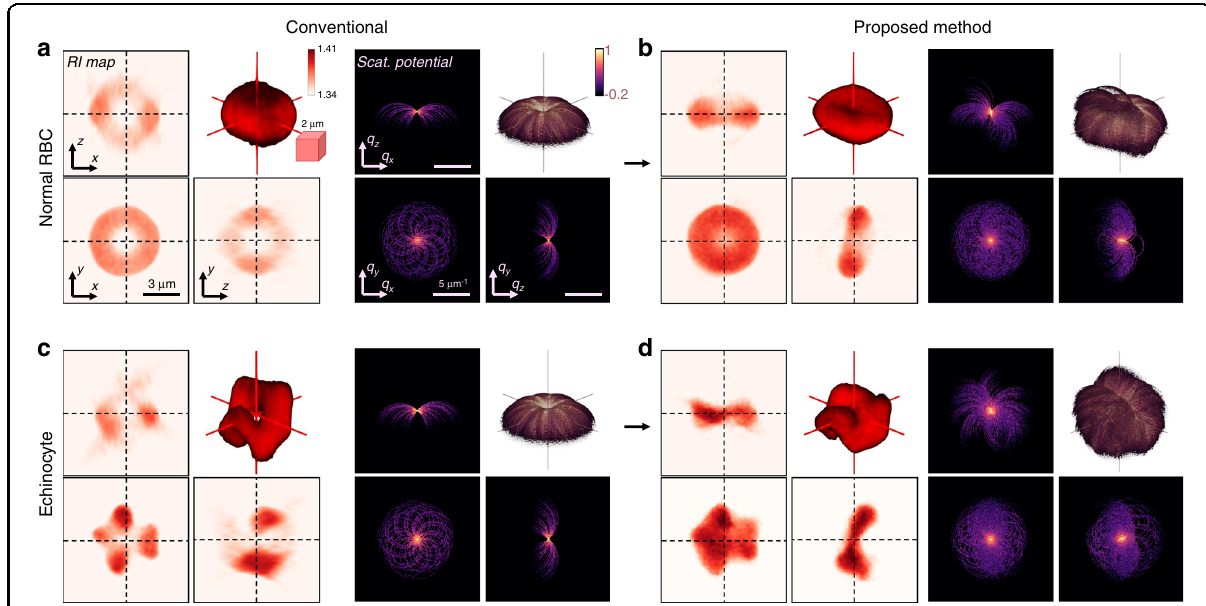
Fig. 4 3D RI reconstruction of live mouse red blood cells (RBCs). a , b RI tomograms and the corresponding scattering potential spectra of ( a ) a normal RBC and ( b ) echinocyte using the conventional ODT. c , d Corresponding results of ( c ) the normal RBC and ( d ) the echinocyte using our proposed method (dashed lines, 2D slice regions; inset, 3D-rendered